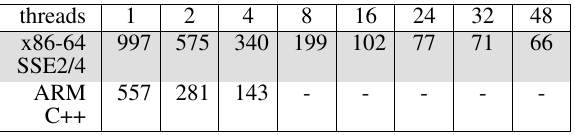
Table 5. Runtime in seconds for different thread counts On both platforms, doubling the number of processing threads lowers the runtime by a factor of 1.69 to 1.98 until the physi- cal CPU cores are exhausted. Hence, the SGM implementation with path-wise multithreading almost scales linearly on the test machines. There is a marginal speedup when the logical cores are included and competition for memory bandwidth and arith- metic units of the processor